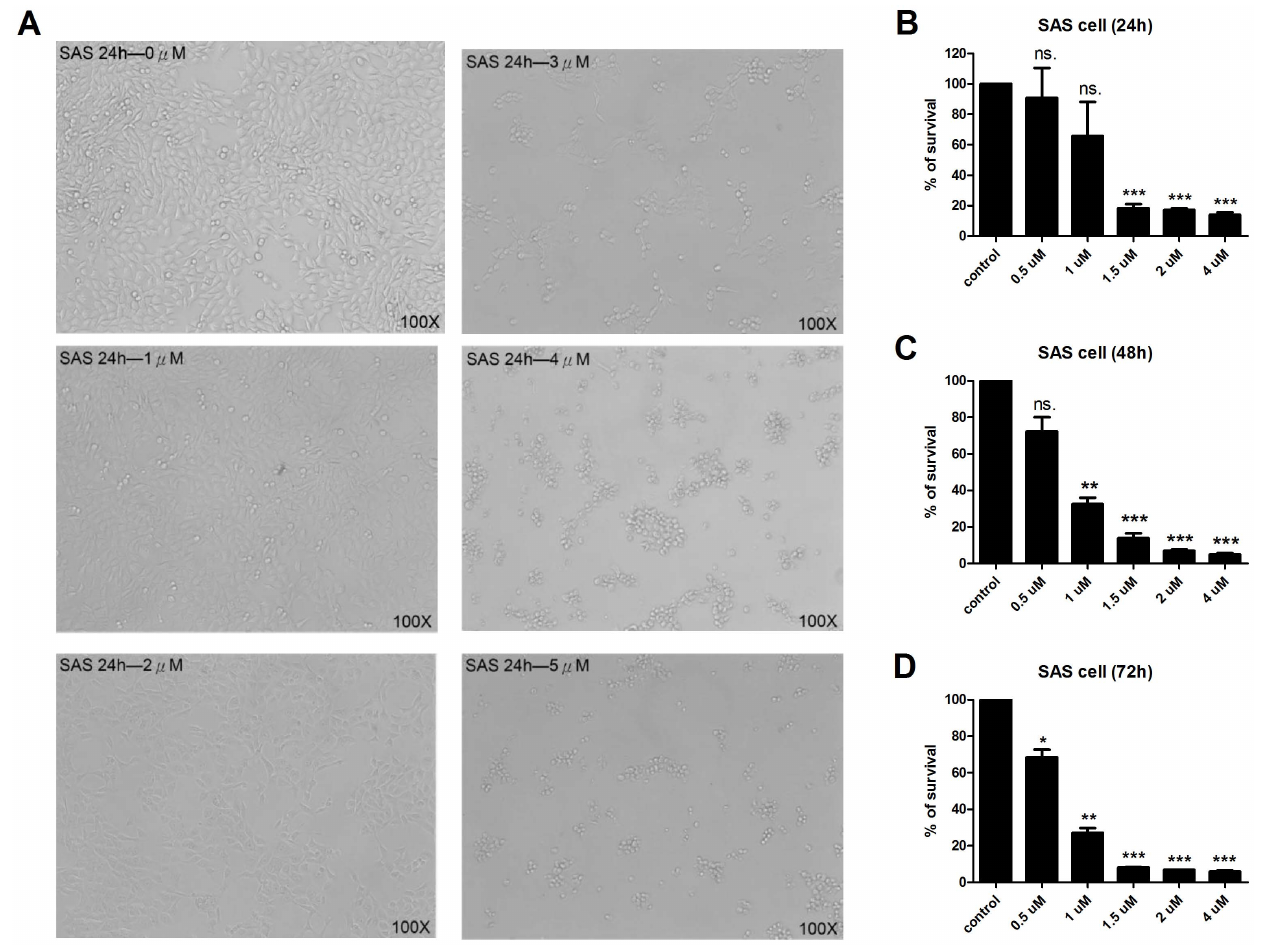
Figure 1. NSC745885 inhibits SAS cell growth in vitro. (A) Morphological changes in SAS cells. Cells were treated with indicated dosages of NSC745885 for 24 hours. Dosages higher than 3 m M caused cell death in SAS cells. The survival of NSC745885 treated SAS cells was assessed by MTT assay at various times and dosages. (B) At 24 hours post treatment, the survival of SAS cells showed a significant difference at the dosages higher than 1 m M. (C) At 48 hours, treatment at 1 m M or higher than that dosages of NSC745885 exhibited a significant anti-cancer effect. (D) After 72 hours of treatment, the IC50 of NSC745885 was 0.85 m M in SAS cells. Survival proportion (%) indicated the relative value compared with vehicle control groups in SAS (n = 3; *, P , 0.05; **, P , 0.01; ***, P , 0.001; ns., non-significant).